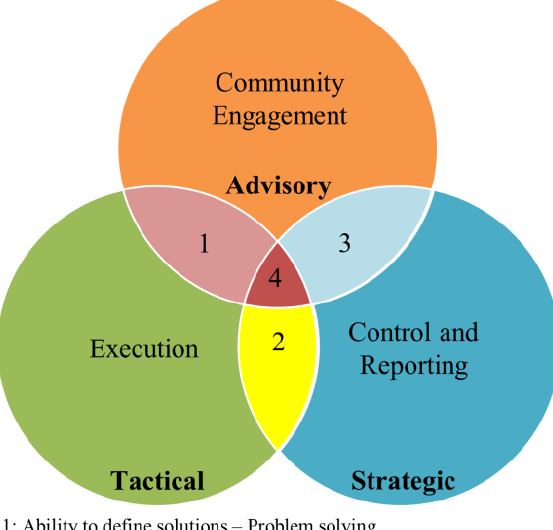
Figure 5. Areas of the governance model: Advisory, Tactical and Strategic.